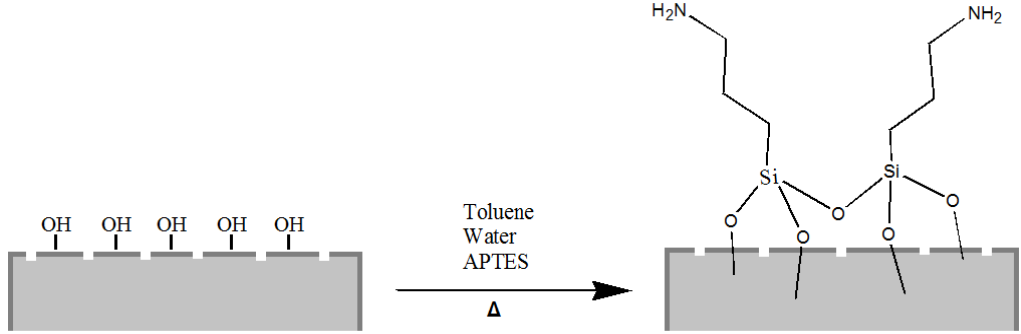
Figure 2. Scheme of diatom frustule passivation with 3-aminopropyl-trimethoxysilane (APTES).